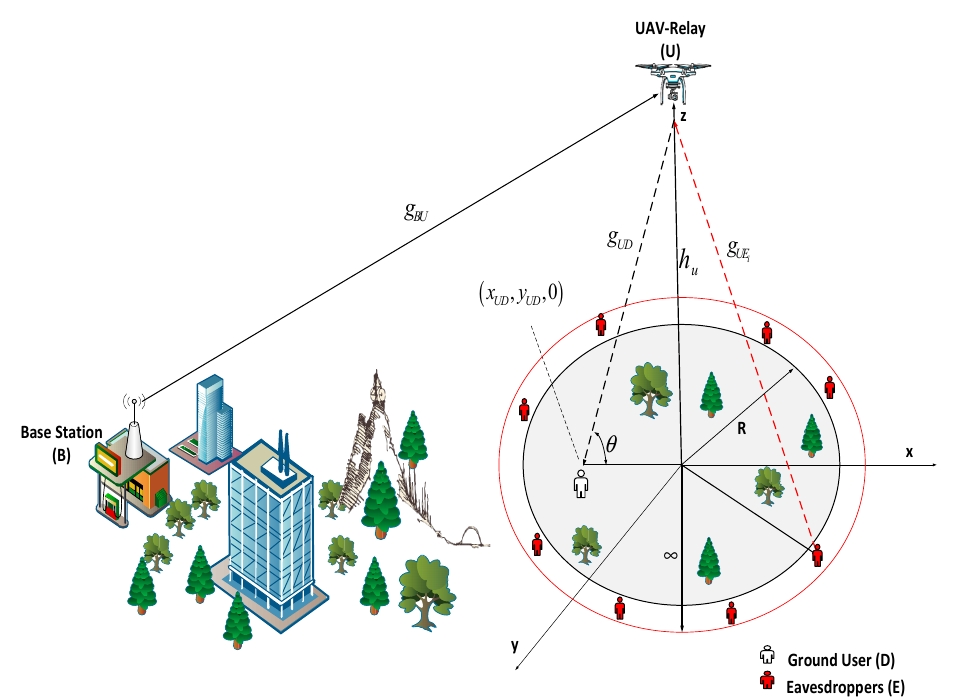
Figure 1. Basic model for a dual-hop UAV-based relay